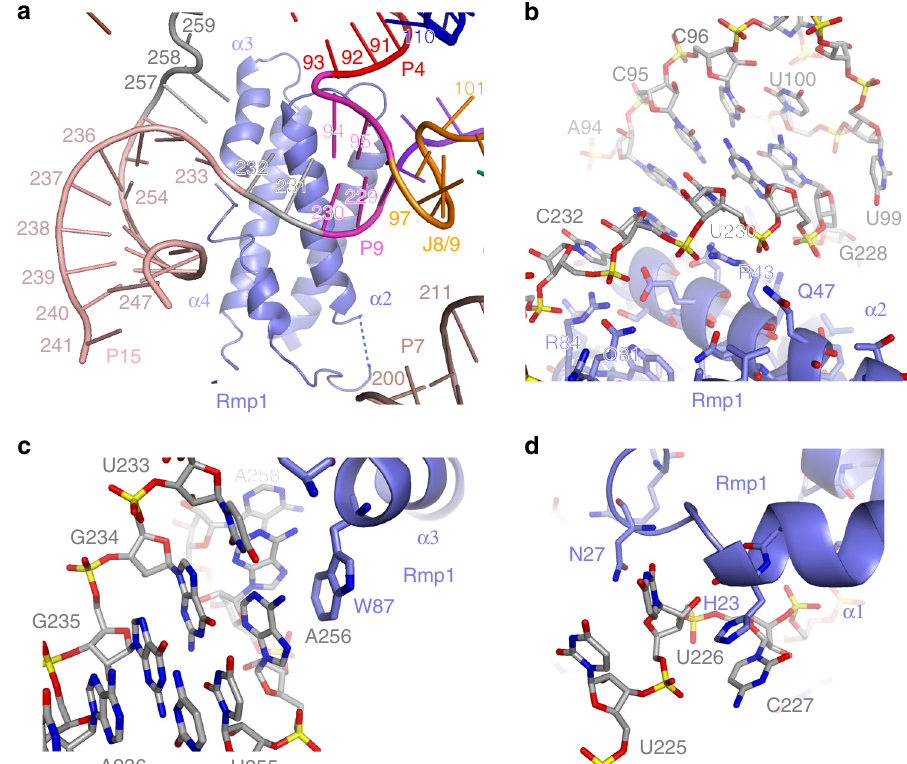
Fig. 5 Interactions of protein Rmp1 with the RNA component of RNase MRP. a – d Rmp1 binds at the foundation of the P15 helical stem, in the vicinity of the catalytic center, interacting with stems P4, P9, and the J7/9 junction. Interactions of Rmp1 with RNase MRP RNA result in a change of the P15 stem orientation compared to that observed in RNase P 21